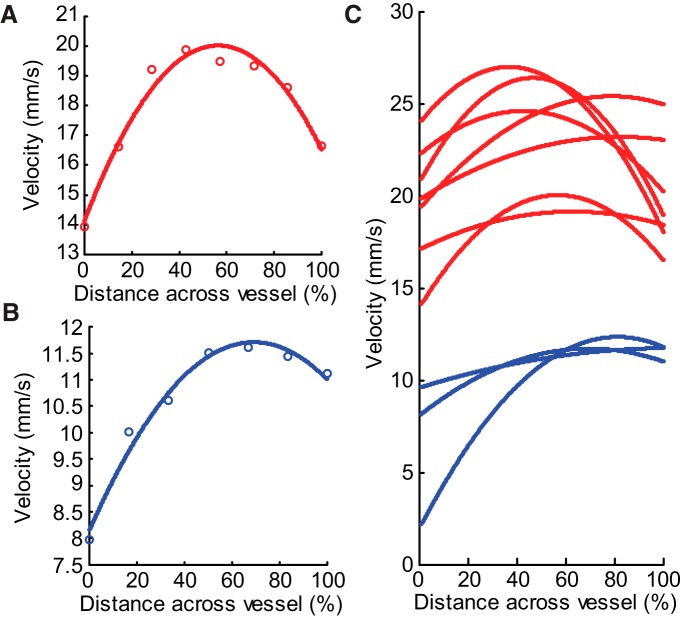
RBC velocity profiles across the width of blood vessels using diagonal line scans. A, B, Velocity was determined at many points across the width of an arteriole (A) and a venule (B) by measuring the angle of fRBC streaks along the diagonal line scan. Velocity measurements were fit with a second-order polynomial (solid lines). C, Parabolic fits of RBC velocities for individual arterioles (red) and venules (blue).